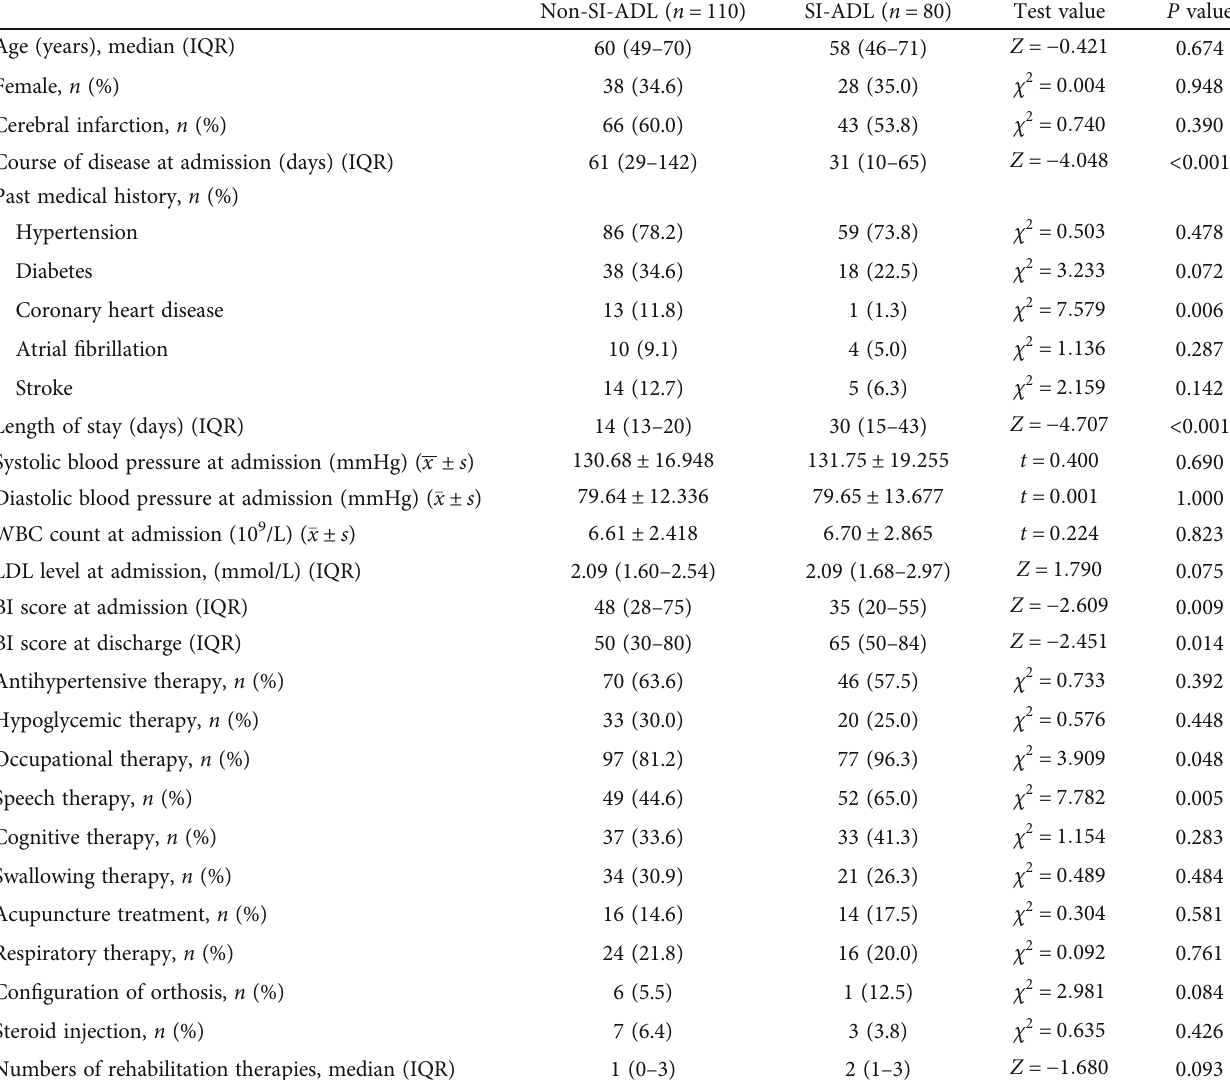
Table 2: Baseline characteristics between SI-ADL and NSI-ADL